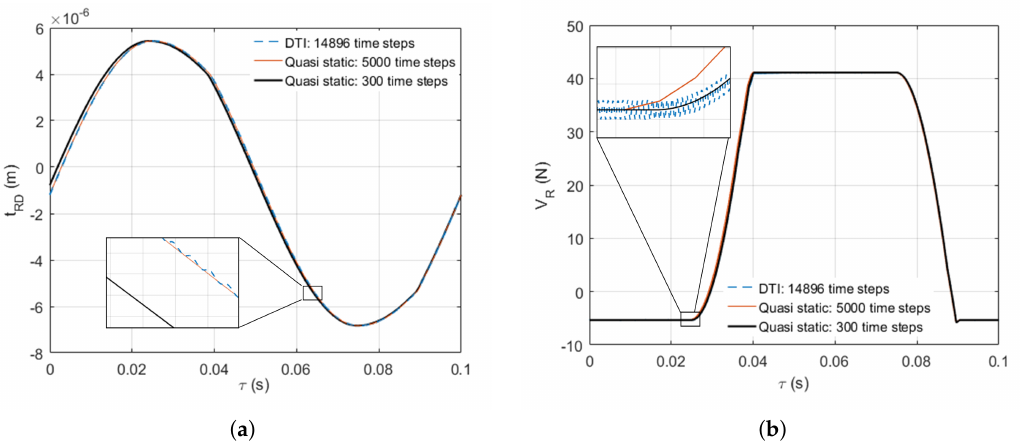
Figure 7. DTI vs. quasi-static results comparison. ( a ) Tangential displacement of the right damper contact point. ( b ) Vertical component of the right contact